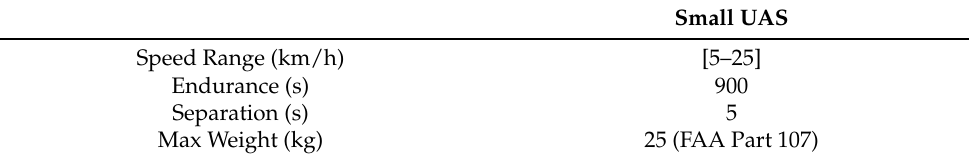
Figure 9. Westbound at 20 m, 3 retail points (W68, W69, W70) and 67 service points (W1 ∼ W67) and 107 directed routes, (Oldbrook, Milton Keynes, United Kingdom). Table 4. sUAS specification.